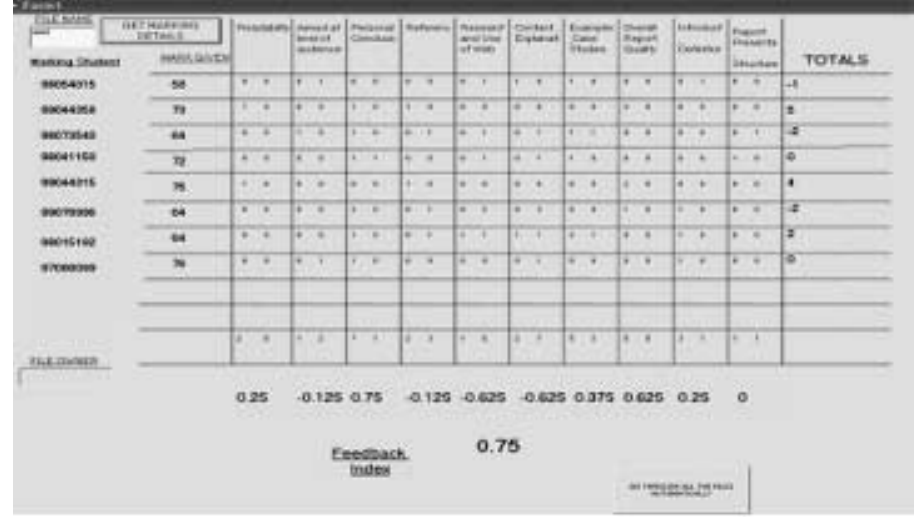
Figure 3. Creation of feedback index for DSandEN